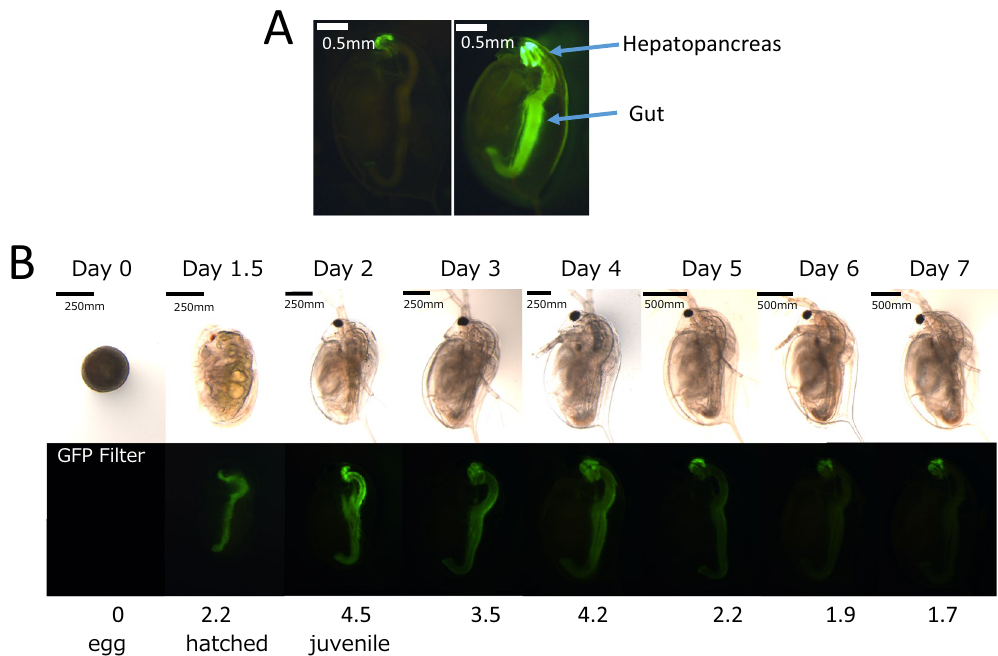
Figure 2. Heavy metal response image of D. magna MetalloG and endogenous GFP expression of D. magna MetalloG. ( A ) D. magna MetalloG daphnia at 7 days old exposed to 30 μM of ZnCl 2 for 48 h (right panel) and control D. magna MetalloG (unexposed) Daphnia ( left panel) at the same age. ( B ) Eggs were obtained from D. magna MetalloG brood chamber after ovulation (assigned as Day 0) and cultured in ADaM. Pictures were taken for one week using the same parameters throughout. Bar = 250 µm. Relative fluorescence intensities were calculated by the method of Törner et al. (23) and indicated under the